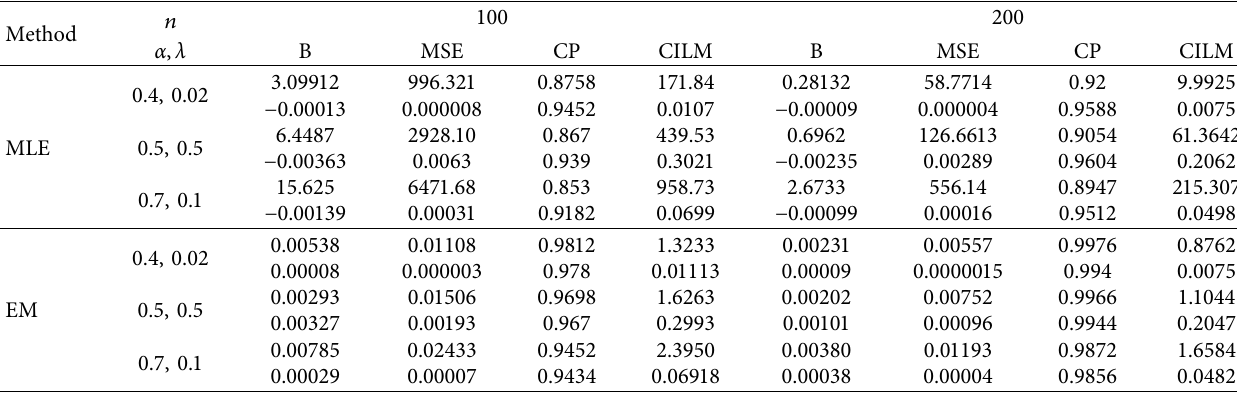
Table 2: Simulation results for MLE and EM estimators of the QL distribution when the censorship rate is p � 0 . 2 (in every cell, the first and second lines are related to α and λ ,